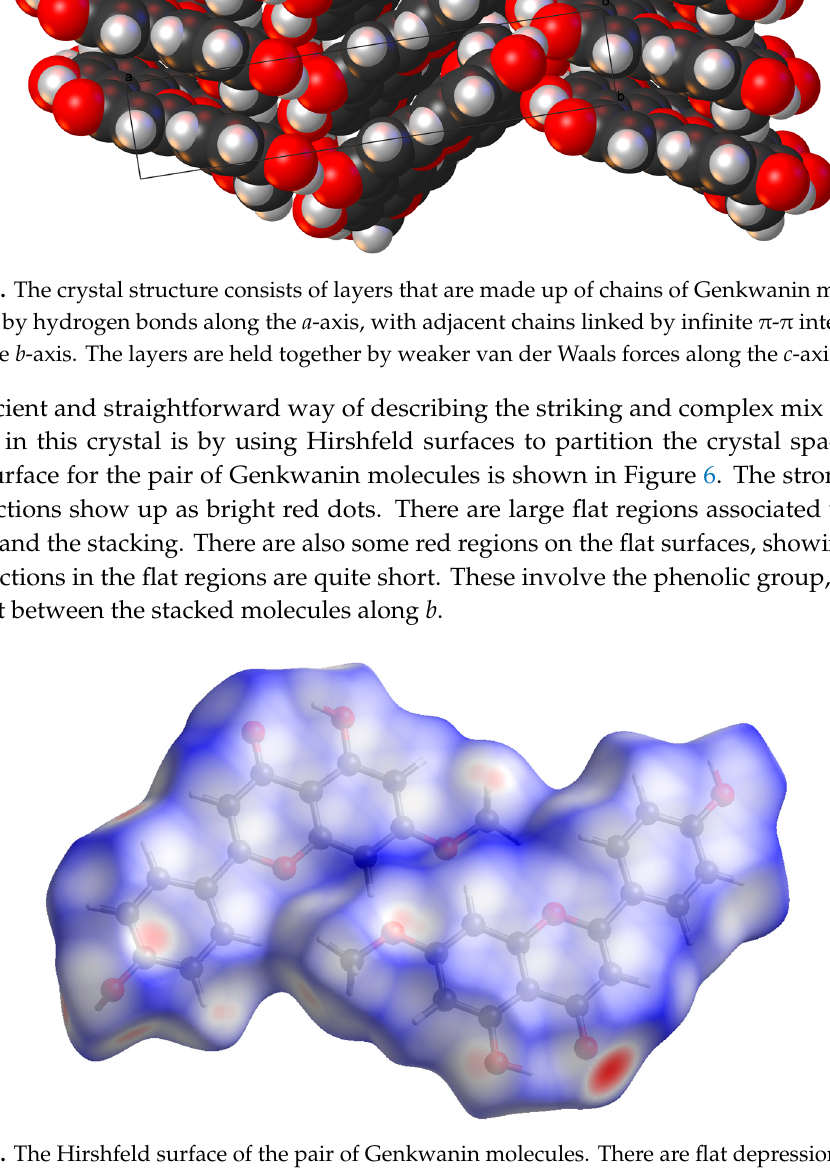
Figure 6. The Hirshfeld surface of the pair of Genkwanin molecules. There are flat depressions on the surface associated with the π - π interactions, dark red spots associated with the hydrogen bonds, and blue regions associated with the weaker van der Waals forces along the c -axis, but there are also some short contacts (light red regions) along the stacking region.